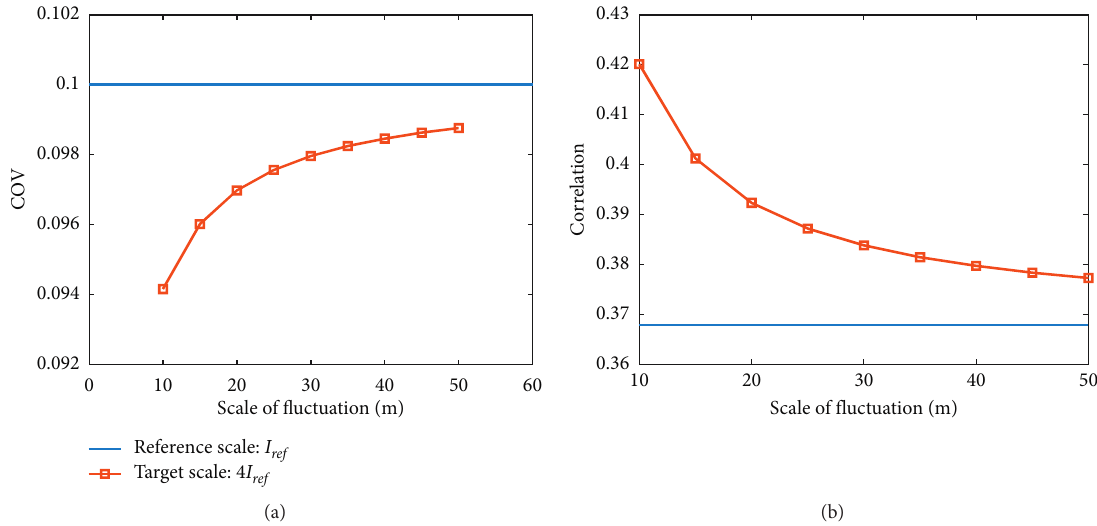
Figure 14: Random field statistics at the target scale for different scales of fluctuation: (a) COV and (b) correlation when the separation distance is half of the scale of